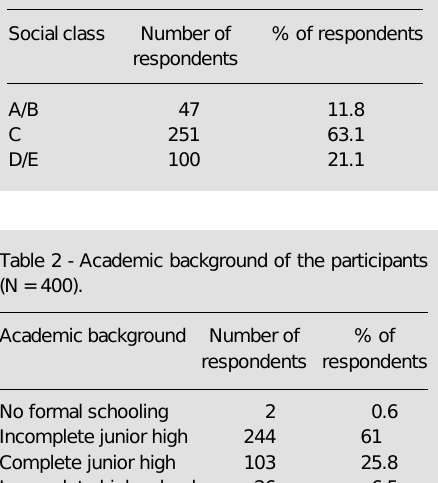
based on ABIPEME criteria (9) (N = 398).